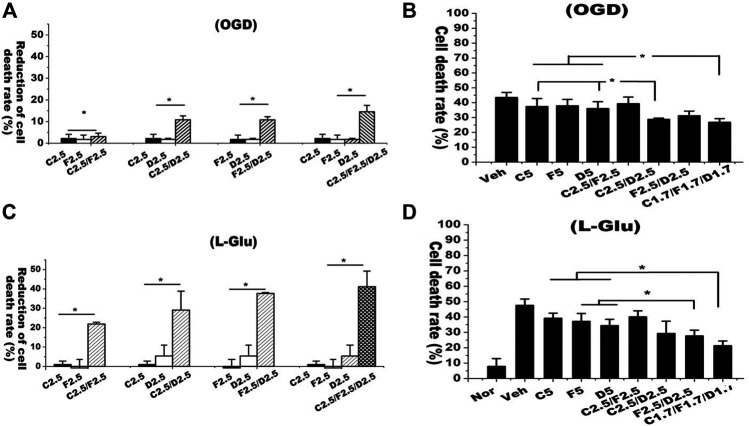
Combined isoflavone treatments had synergetic neuroprotective effects against OGD/RO and l-glutamate-induced cell death. Rate of cell death was determined with LDH release assay. Individual or combined isoflavones including calycosin (C), formononetin (F) and daidzein (D) were added into cultured media prior to OGD/RO or l-glutamate exposures. (A) Mature neurons treated with single isoflavone (2.5 μM) or the combined isoflavones (C2.5 μM/F2.5 μM, C2.5 μM/D2.5 μM, F2.5 μM/D2.5 μM, C2.5 μM/F2.5 μM/D2.5 μM). The reduction of cell death rate was calculated. (B) Mature neurons were treated with single isoflavone (5 μM) or the combined isoflavones (C2.5 μM/F2.5 μM, C2.5 μM/D2.5 μM, F2.5 μM/D2.5 μM, C1.7 μM/F1.7 μM/D1.7 μM). Data were represented as mean ± SD, n = 3, *
p < 0.05. The cell death rate was recorded. (C,D) In l-glutamate experiments, primary cultured neurons were treated with different combinations of isoflavones prior to challenging by 8 mM l-glutamate for 6 h. “Veh” represents vehicle control that receives same volume of dissolvent. L-Glu represents “L-glutamate”. Data were represented as mean ± SD, n = 4, **p < 0.01.